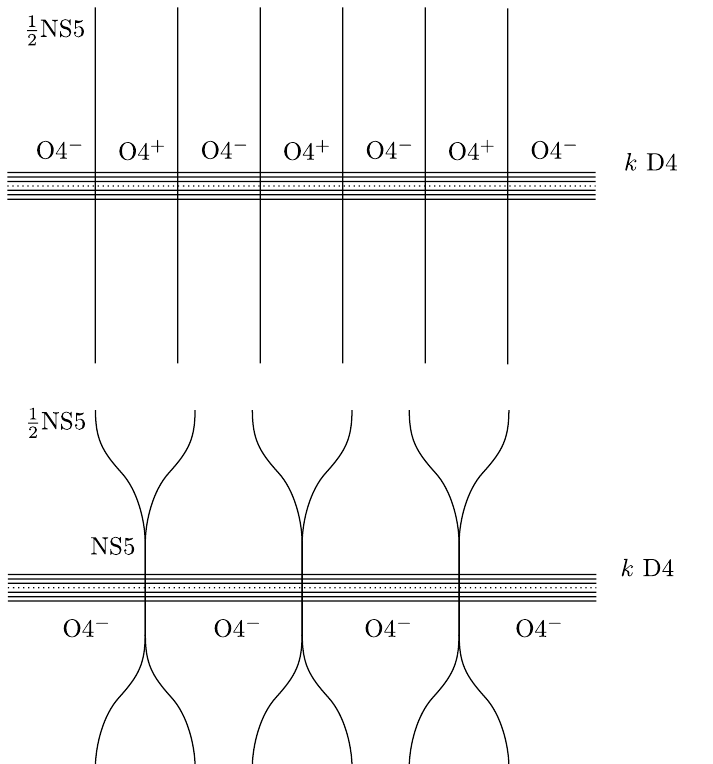
Figure 5 . The upper part of the (cid:12)gure shows the naive brane con(cid:12)guration that reproduces at low energies the quiver theory B N , which is the type IIA con(cid:12)guration on the left of (cid:12)gure 4. O(2 k ) ; Sp( k ) The horizontal axis is the direction 6, and the vertical axis is the direction 5. Periodic identi(cid:12)cation between the left part and the right part is assumed. As a result of the bending described in the text, a more realistic view is pictured in the lower part, where the half-NS5 branes recombine to give full NS5, and the segments of O4 + shrink to vanishing